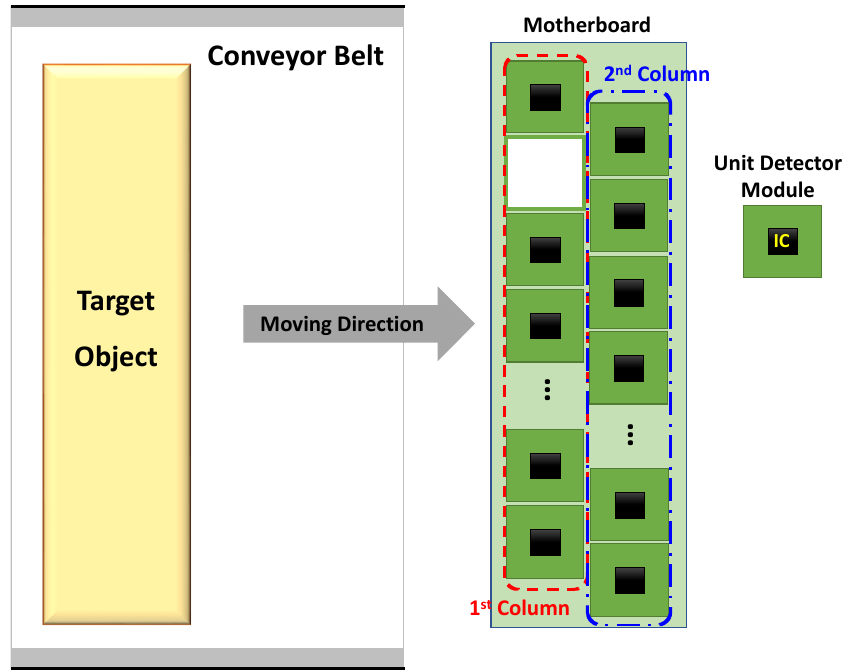
Figure 2. Configuration diagram of the proposed detector array.